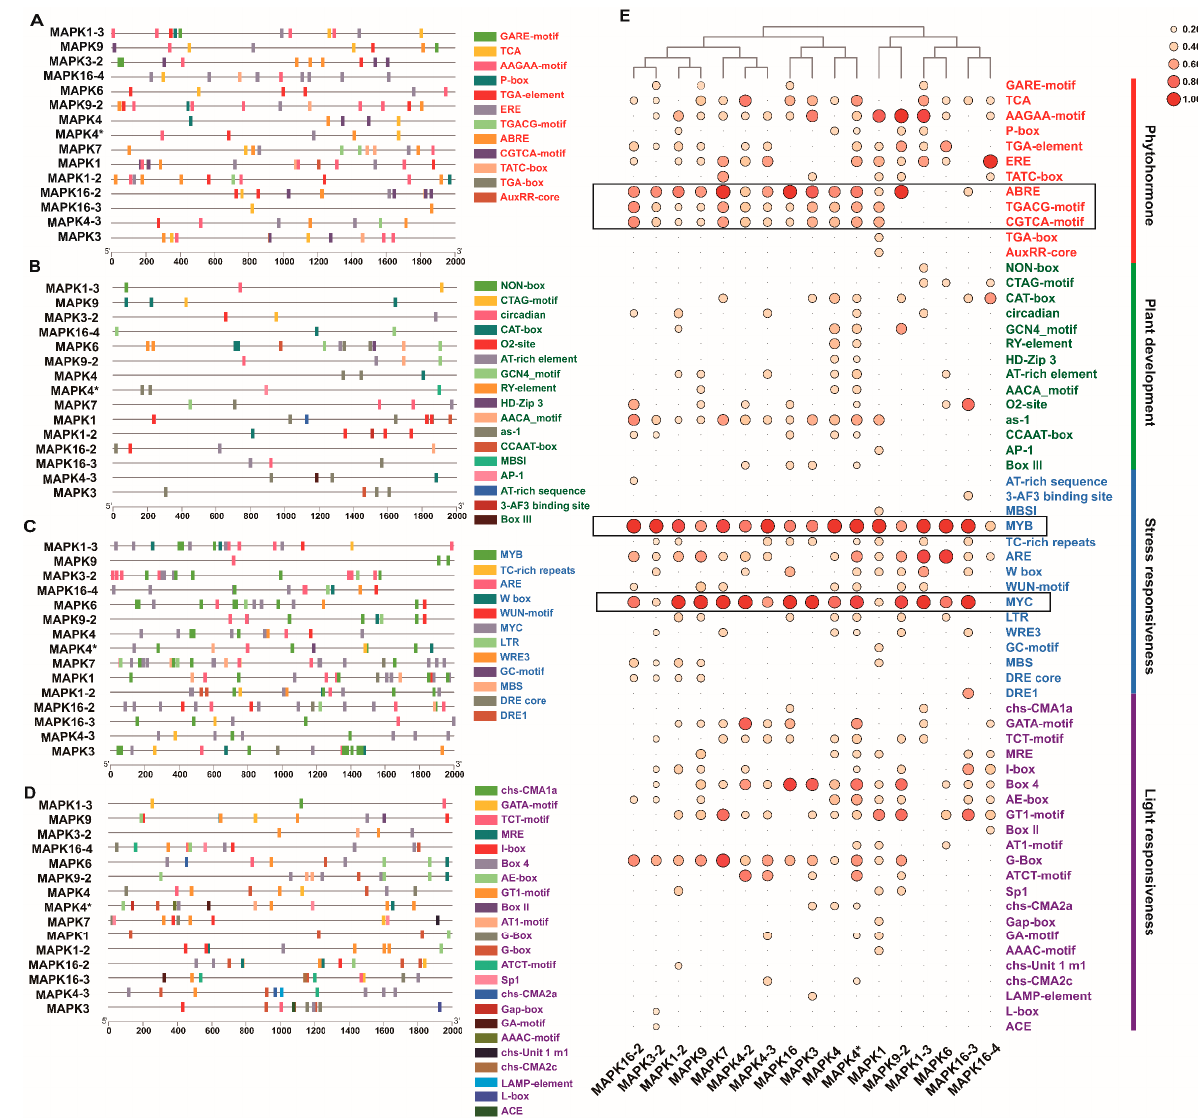
Figure 7. Promoter analysis of LsMAPKs . Location diagram of cis-acting elements related to phytohormones ( A ), plant development ( B ), stress responsiveness ( C ), and light responsiveness ( D ). ( E ) Quantity heatmap of all instantaneously acting elements.